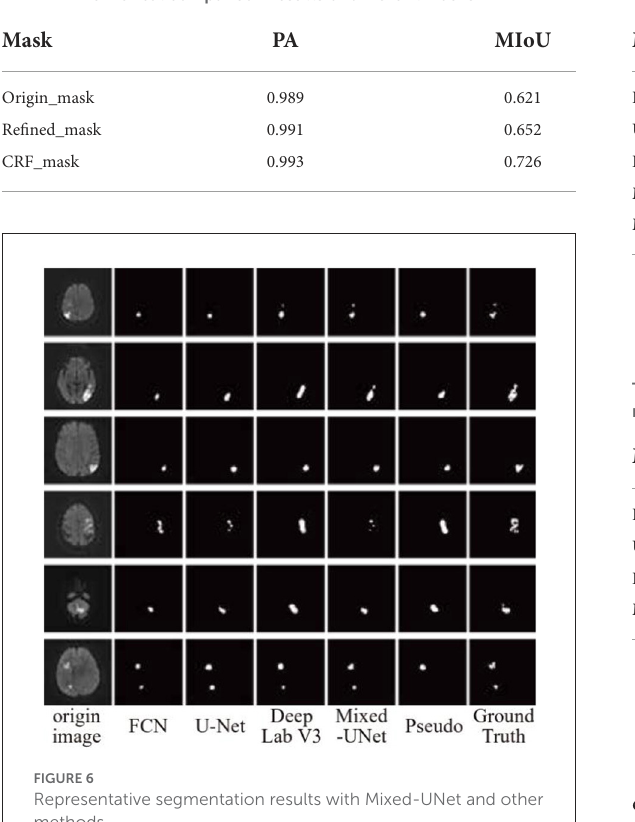
FIGURE6 Representative segmentation results with Mixed-UNet and other methods.